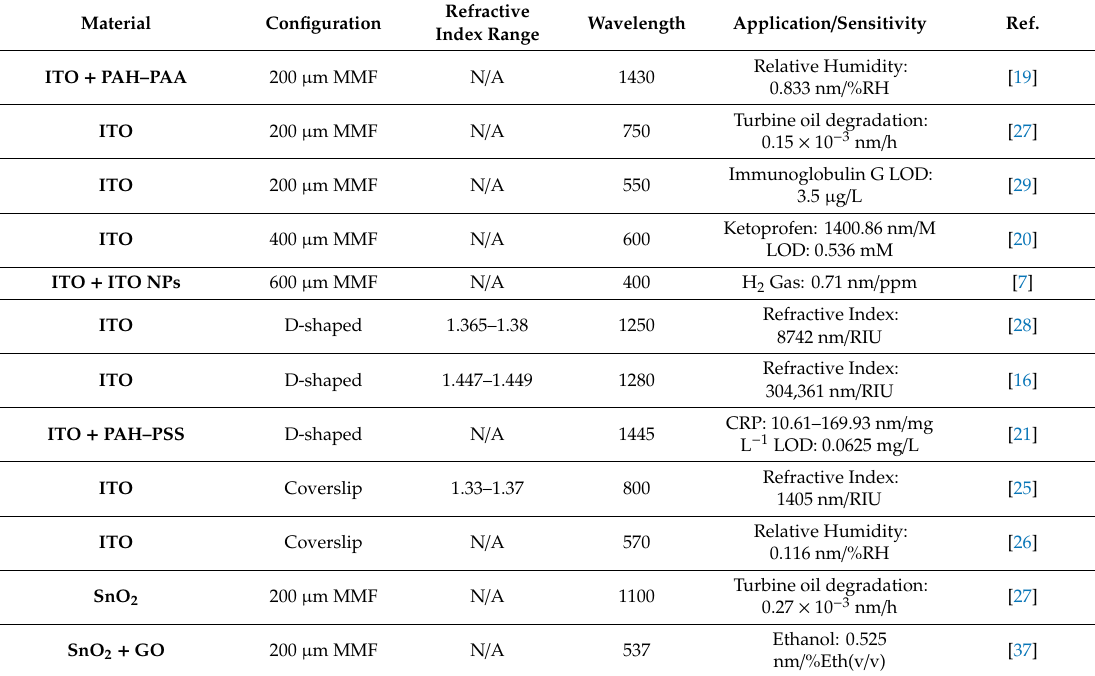
Table 1. Performance of the di ff erent sensors based on the LMR detailed in this paper. A wide range of applications has been developed based on this phenomenon using a variety of materials. The sensors are sorted by coating material, configuration setup, and